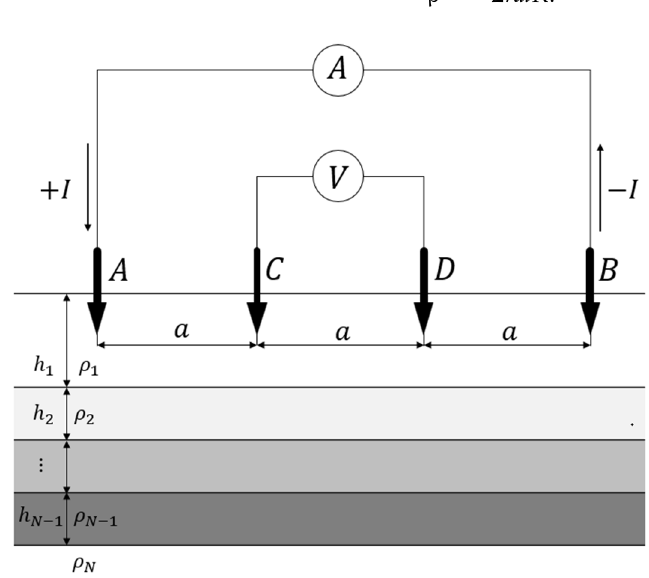
Figure 1. Wenner configuration method and the multilayer soil structure.